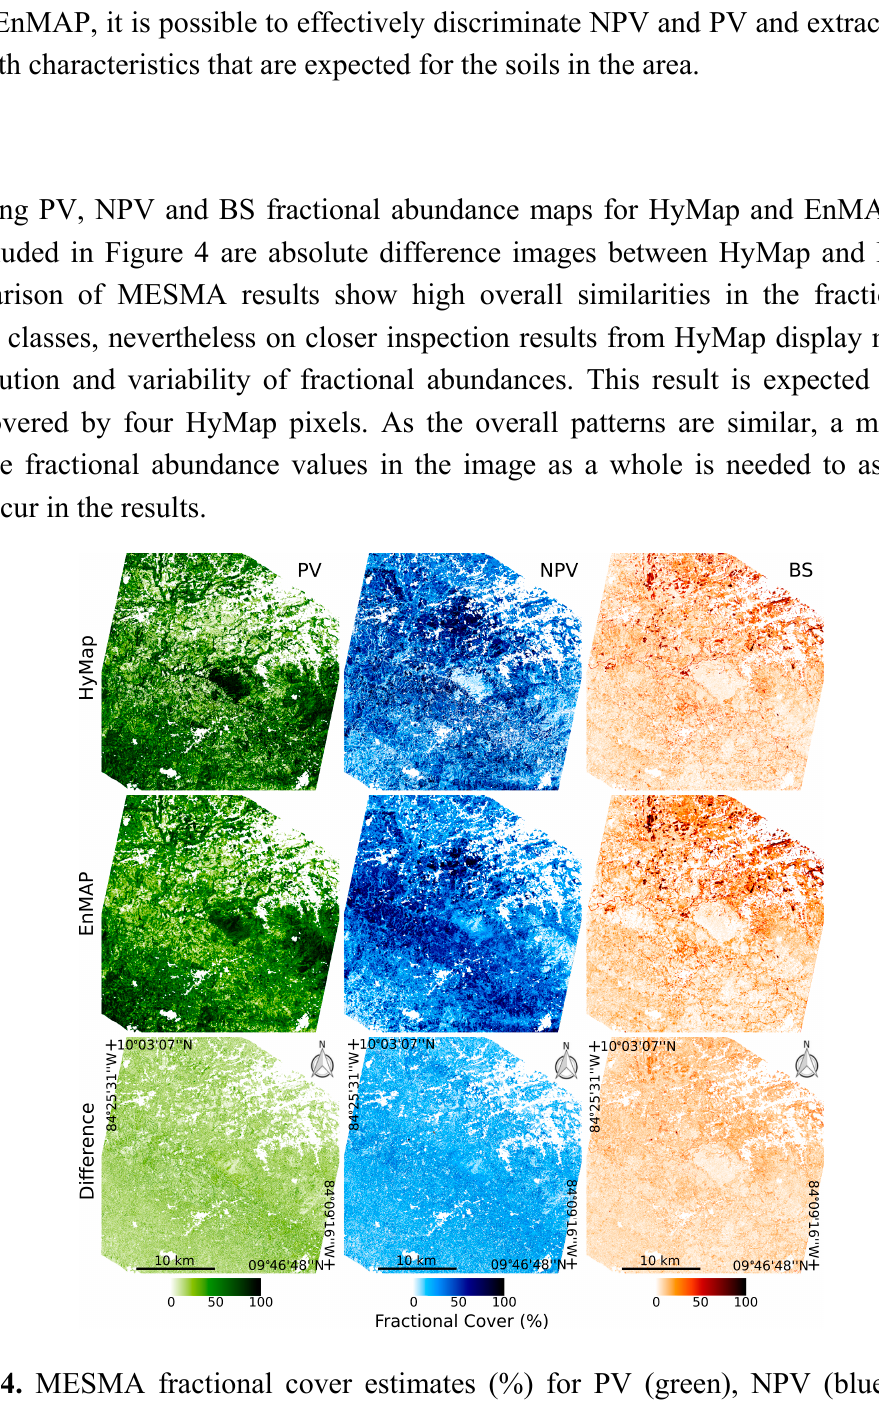
Figure 4. MESMA fractional cover estimates (%) for PV (green), NPV (blue) and BS (orange) and absolute difference